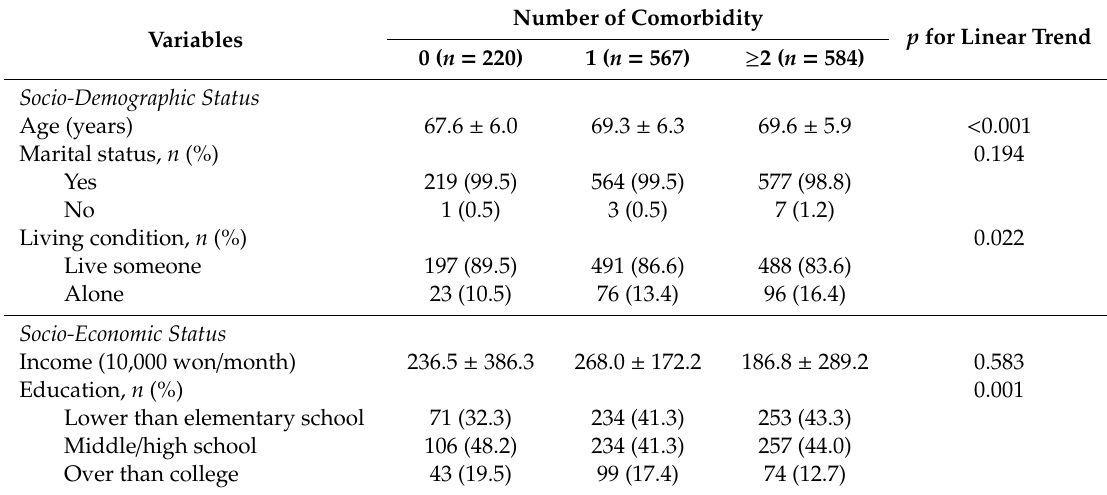
Table 2. Comparison of measurement variables according to number of comorbidity (Mean ±